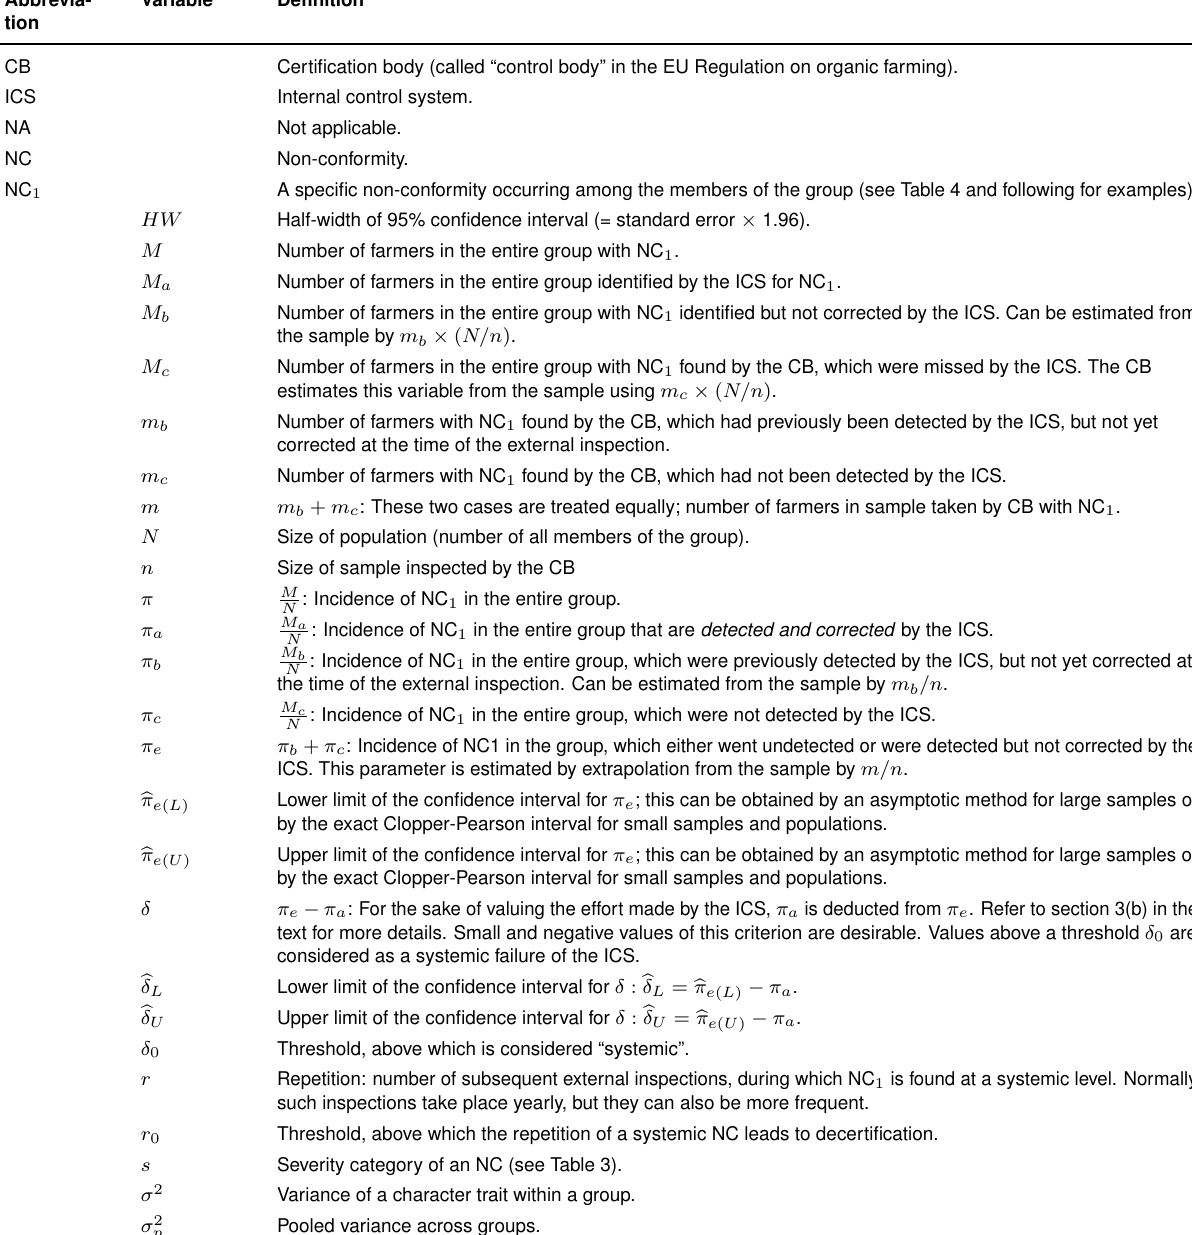
Table 2. Abbreviations and variables used in this article. For an illustration of π , refer to Figure 4, while Figure 5 illustrates some of the other variables. Abbrevia-